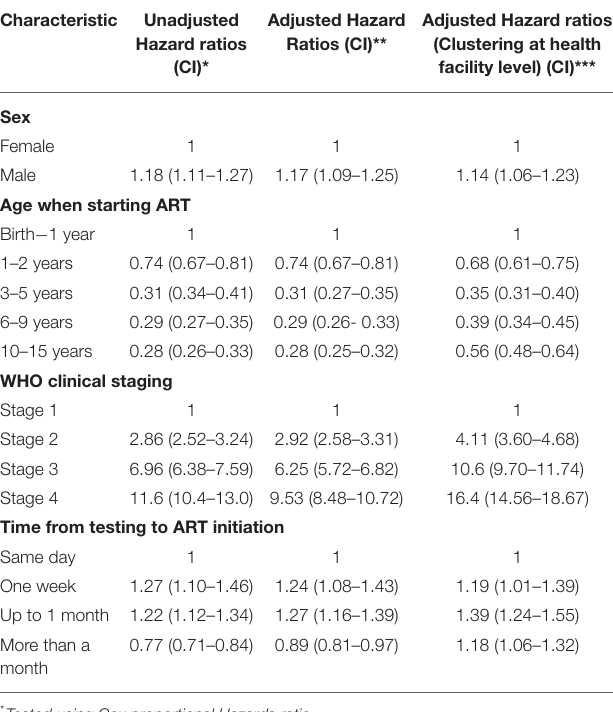
TABLE 3 | Multi-level Proportional hazard ratios for factors associated with mortality among CLHIV on ART in Zambia.